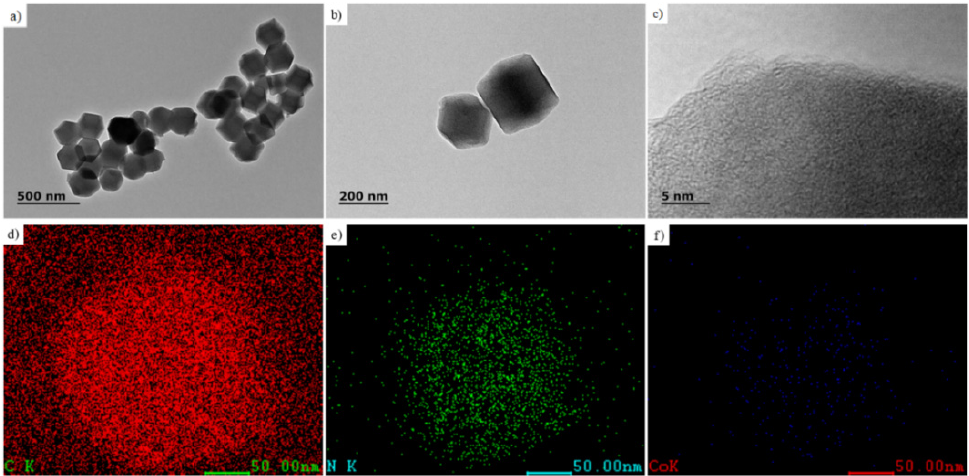
Figure 8. ( a – c ) TEM images showing the morphology of the Co–ZIF–8 catalyst, ( d – f ) TEM mapping showing the distribution of Co, N, C elements.